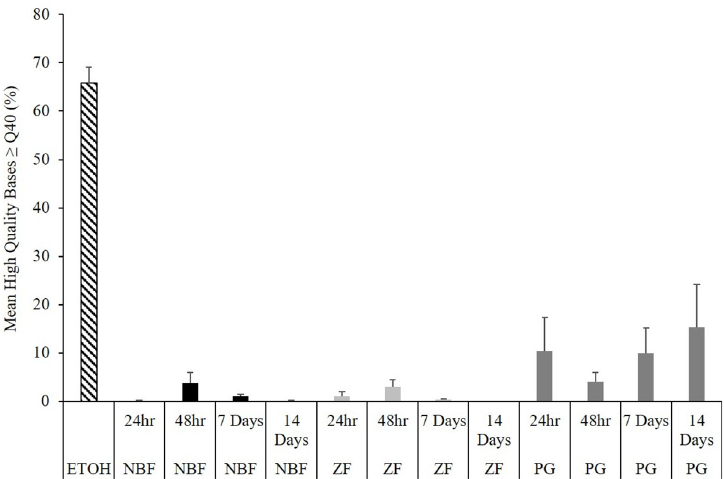
Fig 4. Sanger sequencing quality. Mean (+ SEM) percentage of bases with a Q40 score or above (indicative of high quality sequencing). Samples preserved in 95% ethanol (ETOH) were included as controls routinely used for DNA